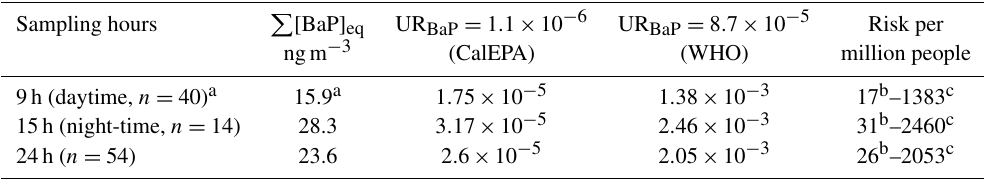
Table 3. Average concentration of P BaP eq in nanograms per cubic metre (ngm − 3 ) and cancer risk assessment for the sum of 16 PAHs, 1 OPAH and 6